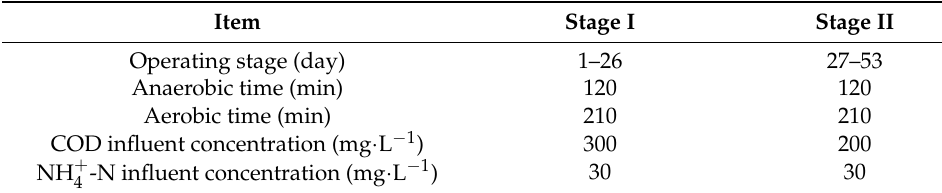
Table 1. Influent concentration of SNDPR systems at different stage.